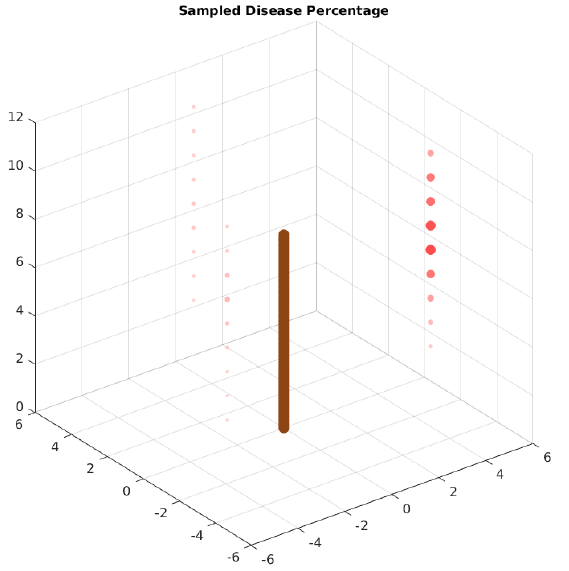
Figure 31. Case study sampling distribution. The larger and more colorful red dots have a bigger percentage of diseased leaves. The brown cylinder represents the main tree trunk.